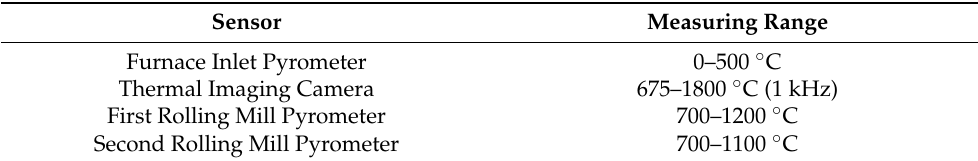
Table 2. Thermal imaging camera’s and pyrometers’ measuring